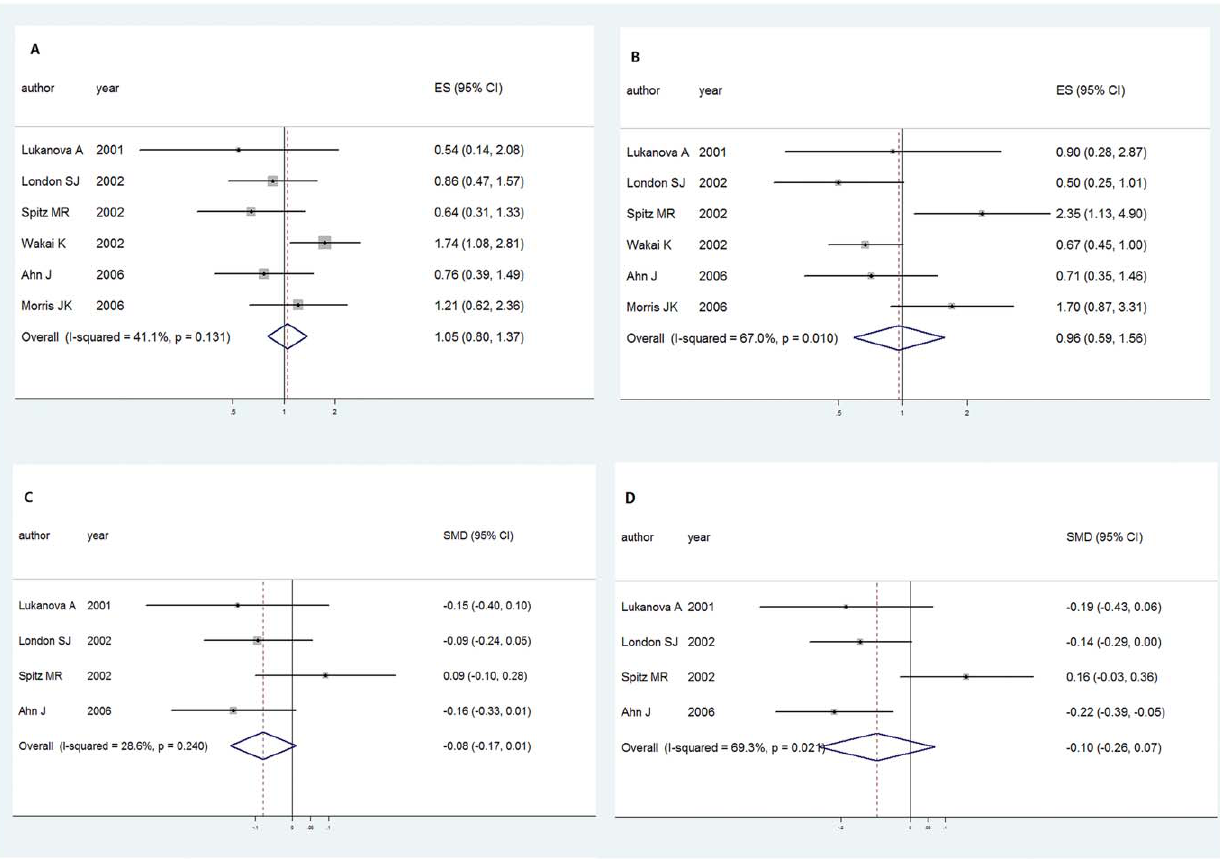
Figure 2. Forest plot of cancer risk associated with the IGF-1 and IGFBP-3 in nested case-control studies. A. Odds ratios with corresponding 95% CIs of the circulating IGF-1 level of individual studies and pooled data of the nested case-control studies. B. Odds ratios with corresponding 95% CIs of the circulating IGFBP-3 level of individual studies and pooled data of the nested case-control studies. C. Standard mean differences with corresponding 95% CIs of the circulating IGF-1 level of individual studies and pooled data of the nested case-control studies. D. Standard mean differences with corresponding 95% CIs of the circulating IGFBP-3 level of individual studies and pooled data of the nested case- control studies.